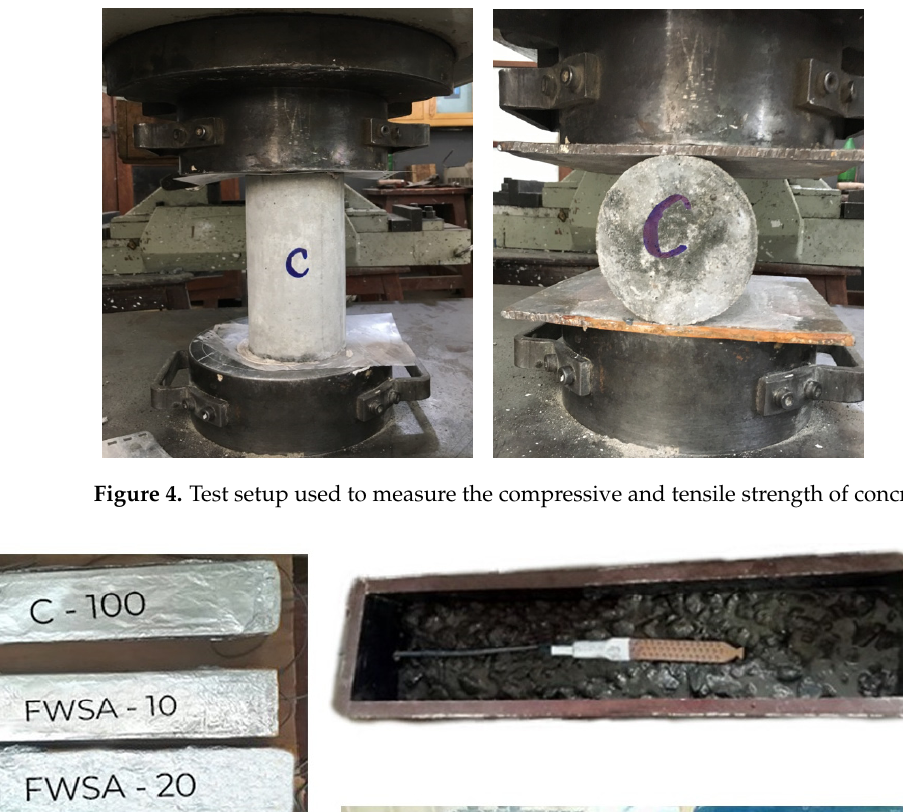
Figure 5. Experimental setup used for measurement of autogenous shrinkage of concrete beams.